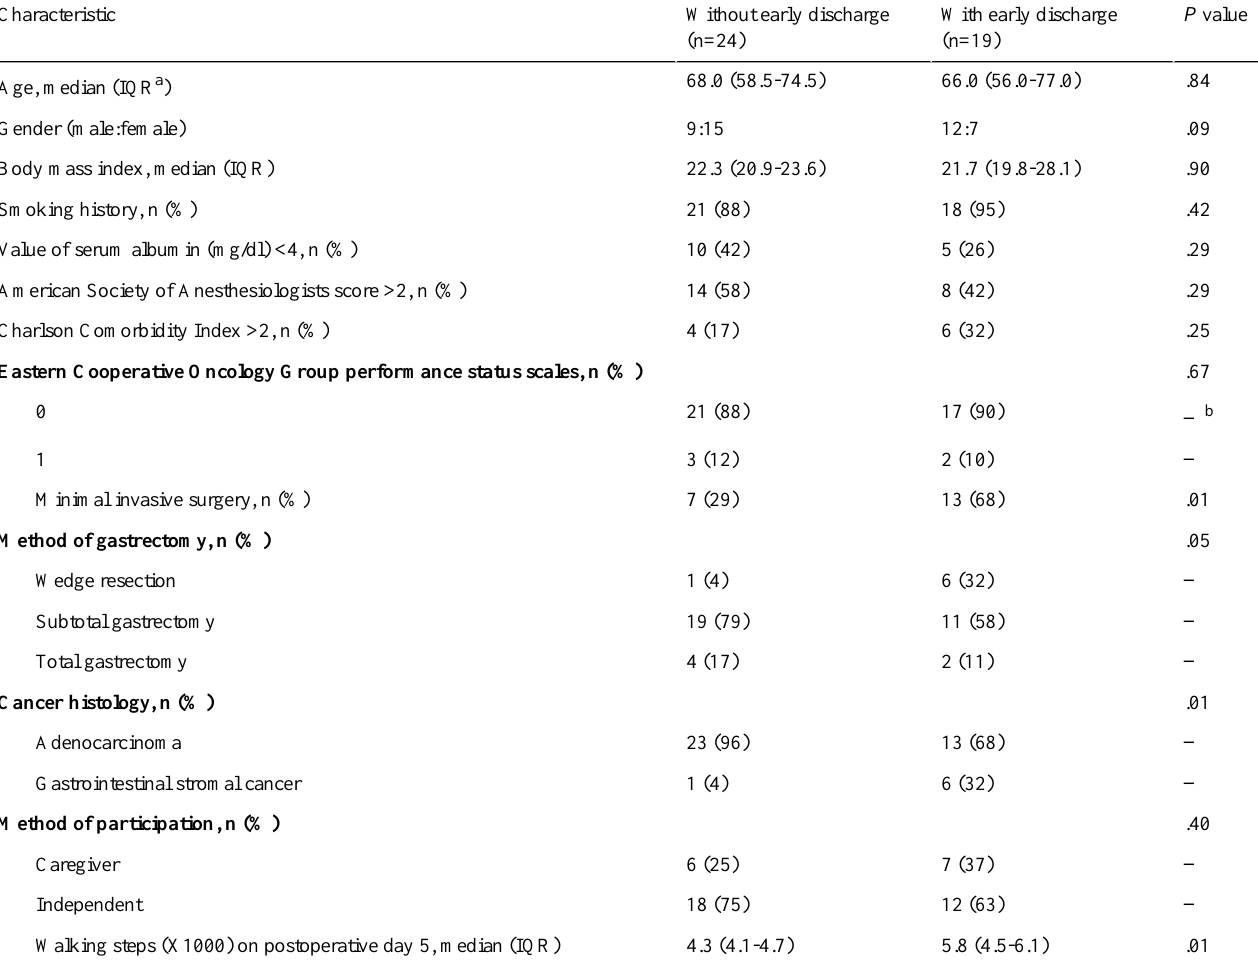
Table 2. Comparison of the study subjects with early discharge and without early